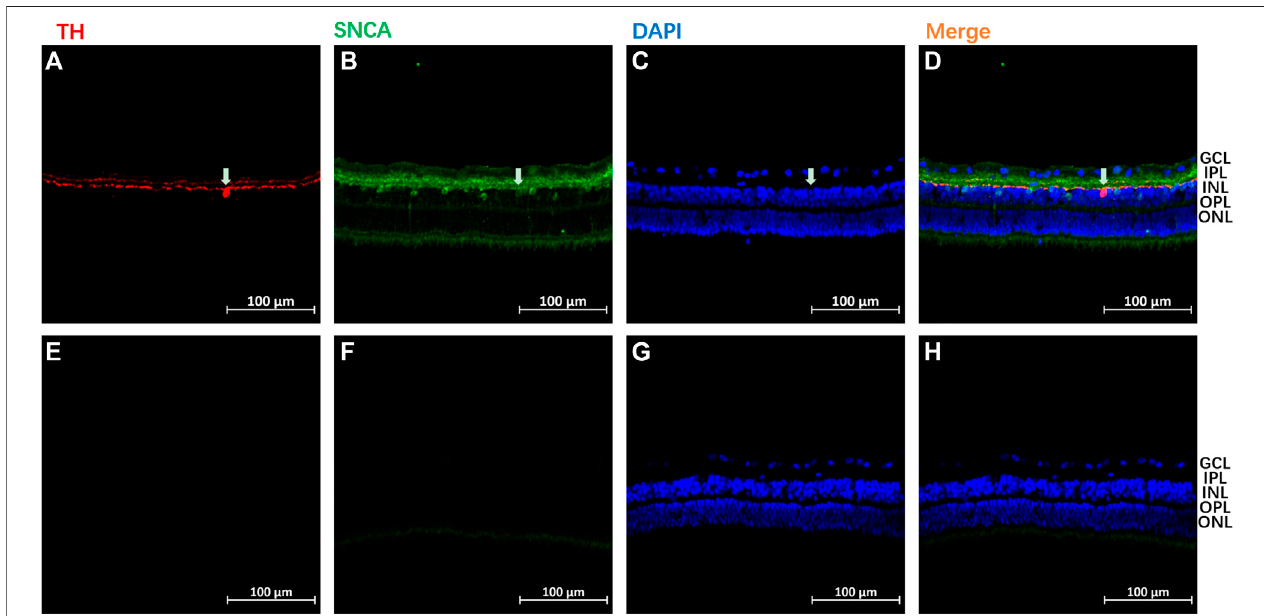
FIGURE 9 | A representative immunoreactivity pattern of α -synuclein (SNCA) and Tyrosine hydroxylase (TH) in the retina of normal guinea pigs. SNCA immune- stainingusinggreen,andTHstainingusingredinpanelsof (A – D) .Thepanelsof (E – H) representedthenegativecontrolsofstaining,slidewasnotincubatedwithprimary antibodies during staining. The following abbreviations were used: outer nuclear layer (ONL), ganglion cell layer (GCL), inner nuclear layer (INL), outer plexiform layer (OPL), inner plexiform layer (IPL), and outer segments (OS). Each bar equals 100 μ m.